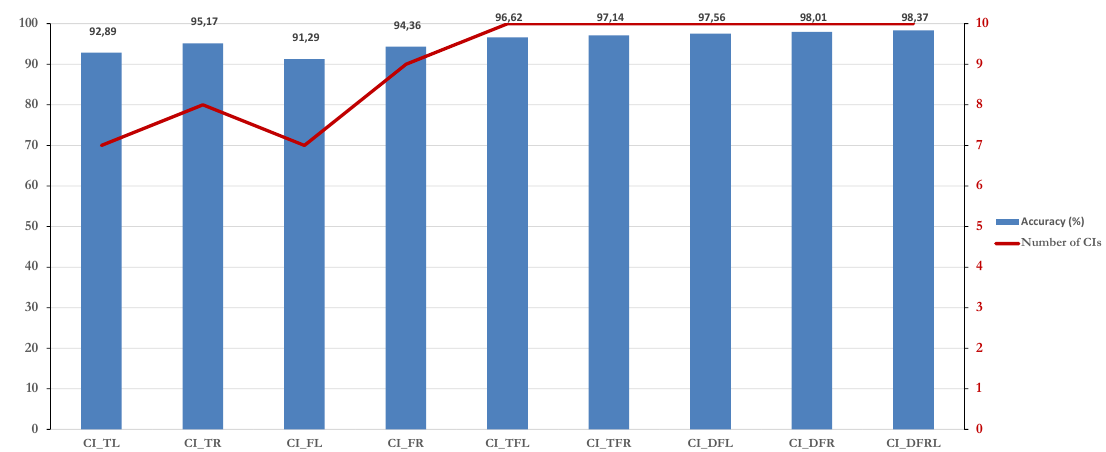
Figure 8. Highest classification accuracy achieved per number of